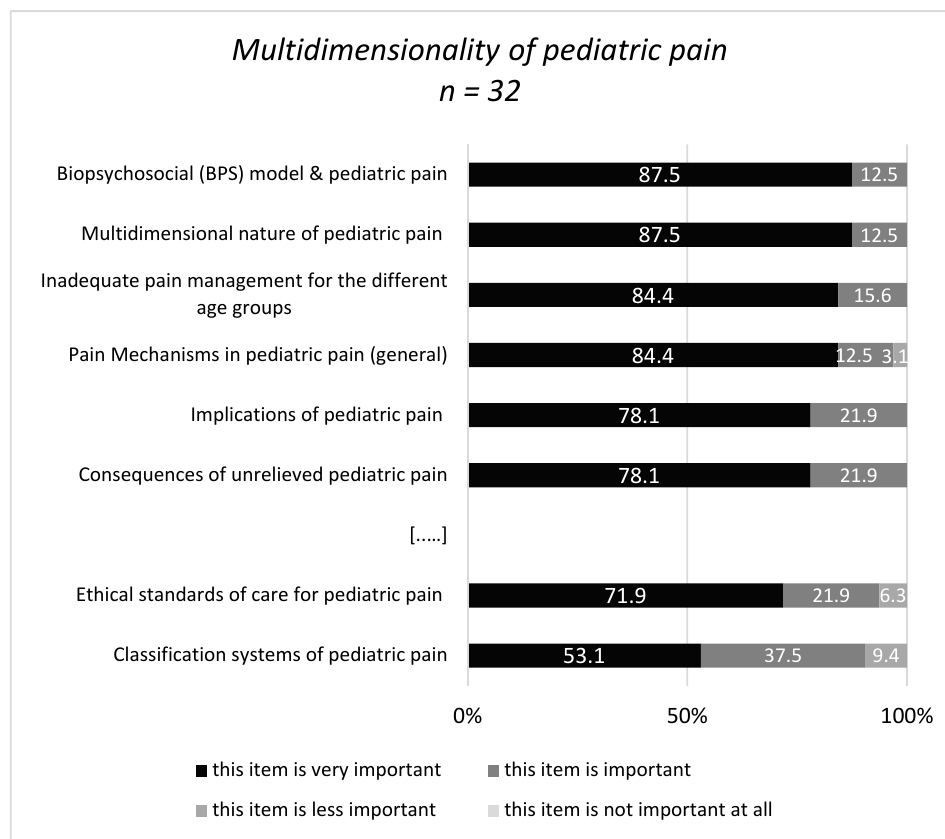
Figure 3. Response categories with highest/lowest accordance in area 1 (Multidimensionality). [ . . . ..]: omission of items in the medium